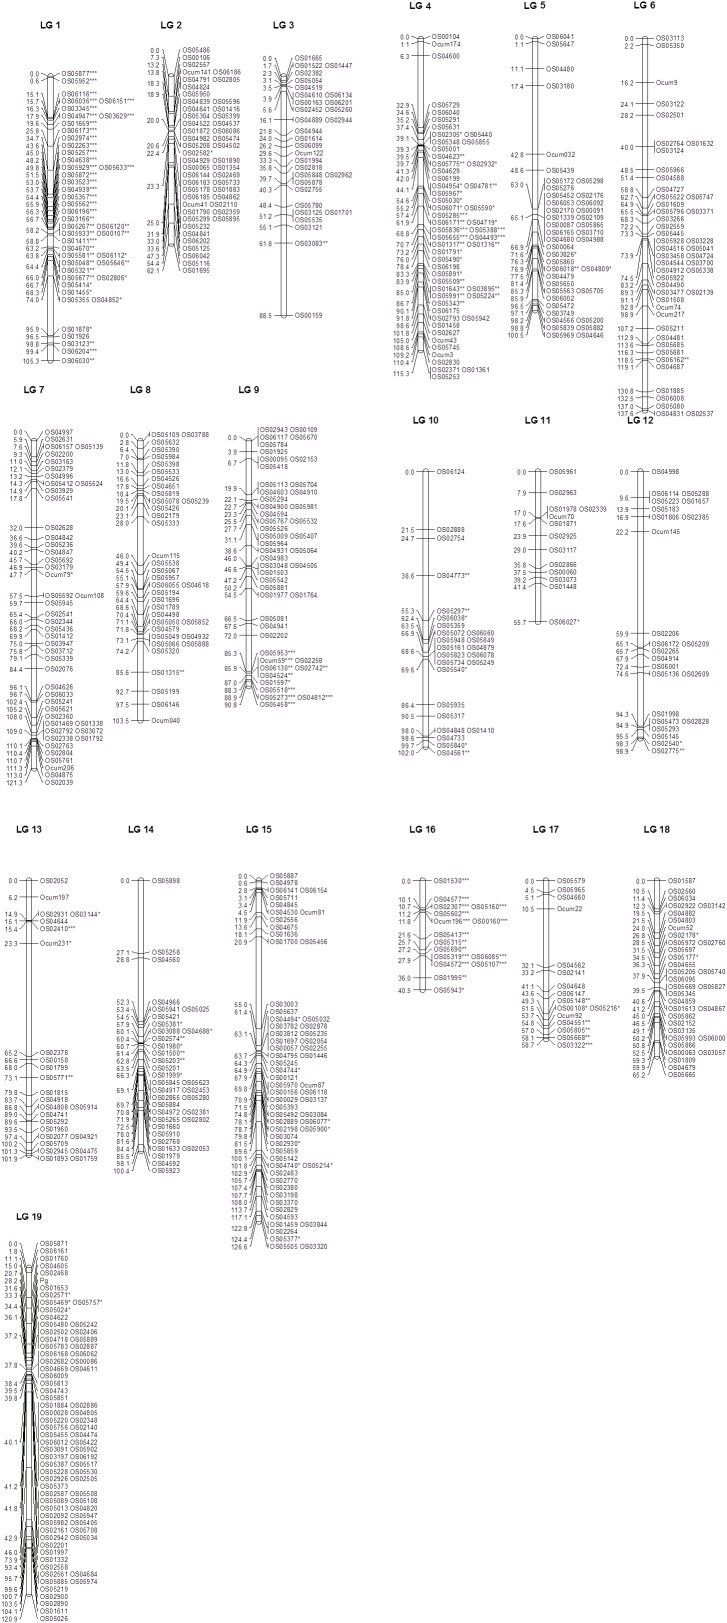
SSR and SNP O. cumana genetic linkage map containing the pigmentation locus Pg. The map is based on segregation of 727 co-dominant SNP and SSR markers, and Pg, in 91 individuals. Linkage groups (LG) follow a randomly selected numeration. Genetic distances are given in centiMorgans (Kosambi) on the left of each LG. The position of the Pg gene associated with plant pigmentation in O. cumana, mapped as a Mendelian trait, is shown at LG19. Prefix Ocum is for SSR marker loci and prefix OS for SNP marker loci. SNP and SSR marker loci labeled as ∗, ∗∗, or ∗∗∗ showed distorted segregation at P < 0.05, P < 0.01, and P < 0.001, respectively.